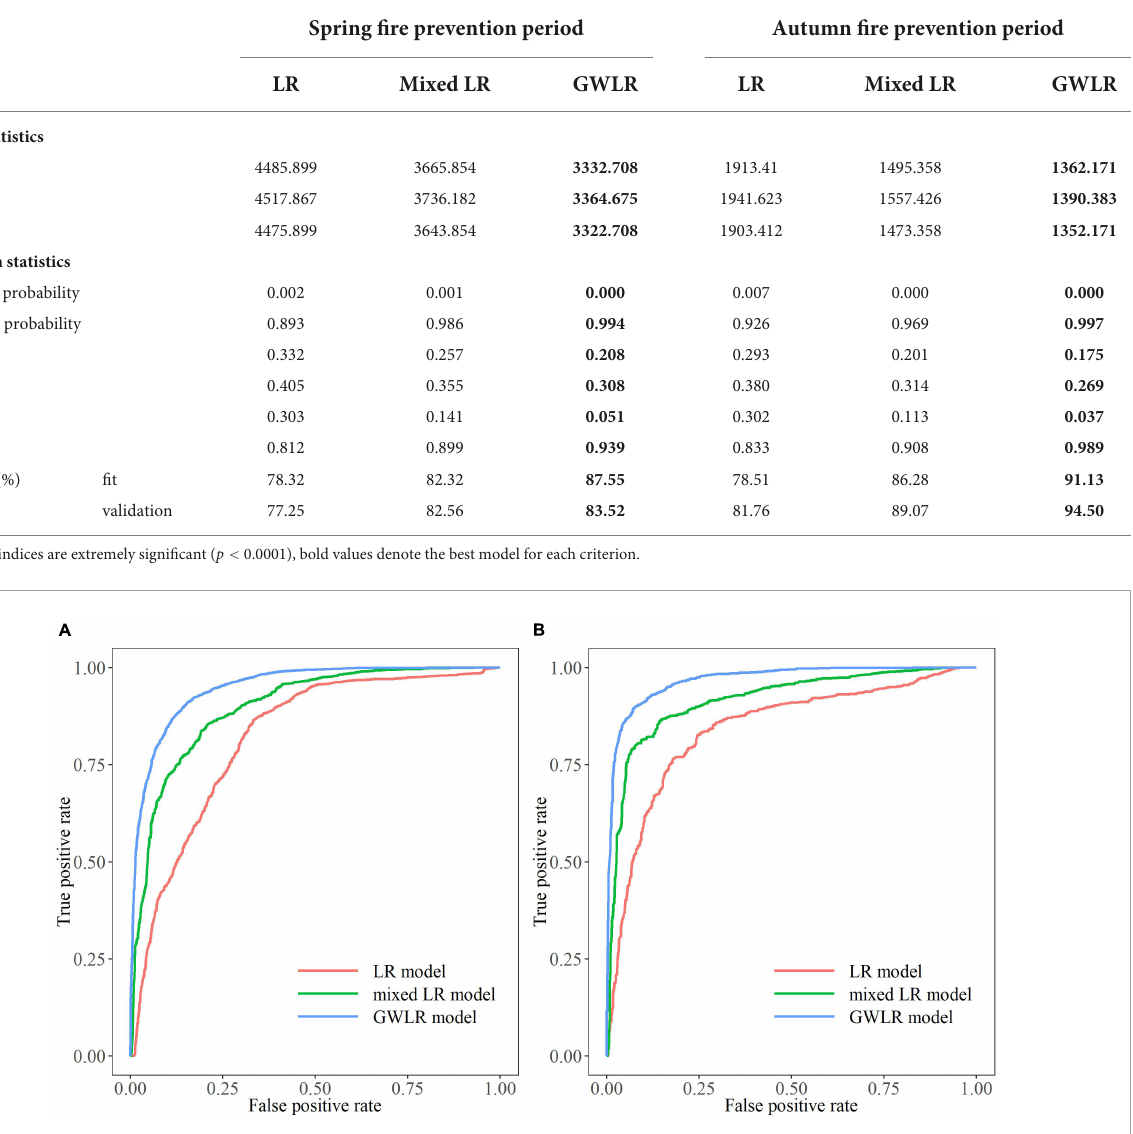
northern and southern regions during autumn fire prevention